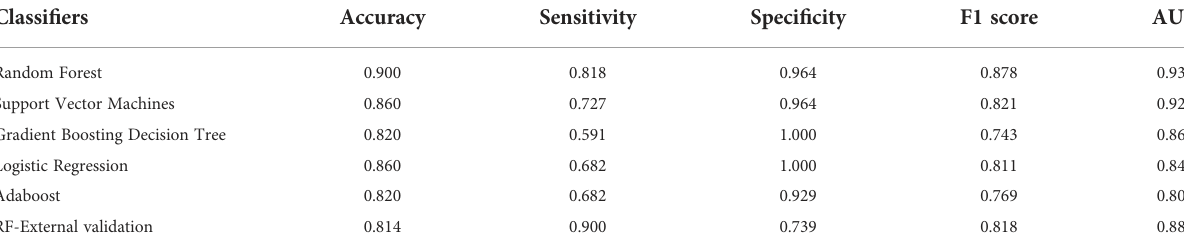
RF indicates Random Forest; AUC, the area under the receiver operating characteristic